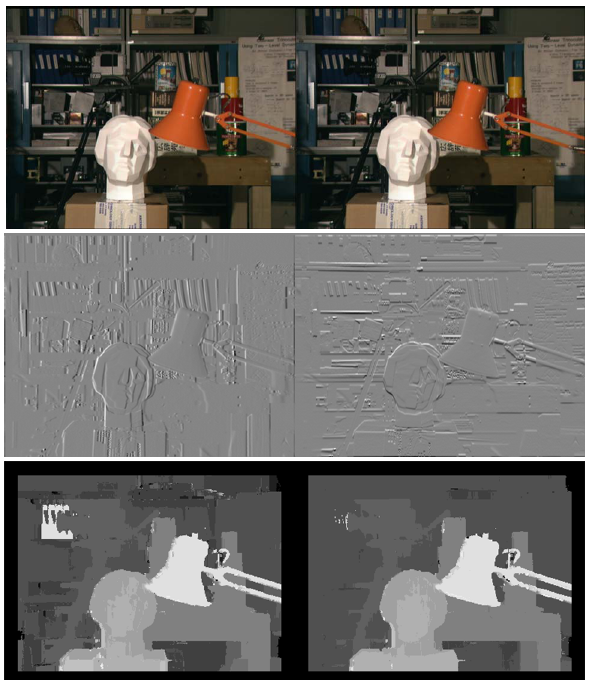
Figure 1. Above: the original Tsukuba stereo-pair. Middle: gra- dients in x (left) and y (right) of the left image on the first chan- nel. Below: disparity map of the left image obtained from Cen- sus on intensity (left) and Census on RGB /gradients with AD in cost function (right) after the aggregation step.